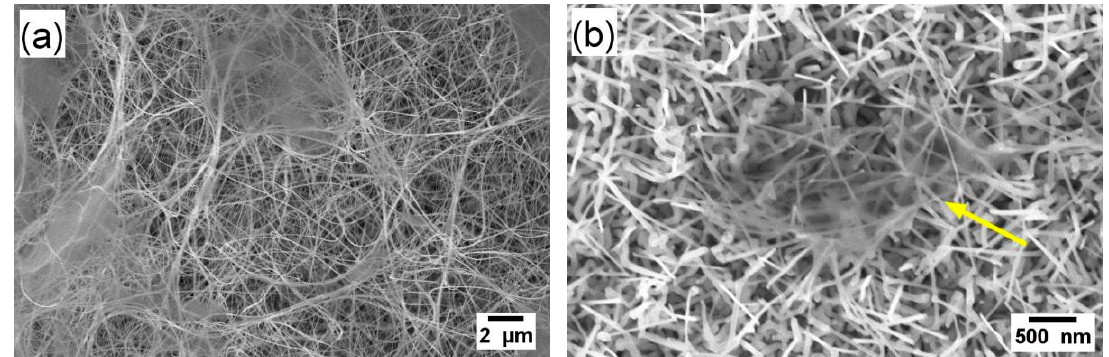
Figure 1. SEM imagers of SnO 2 /rGO composite in different magnifications.( a ) Low magnification; ( b ) High magnification.